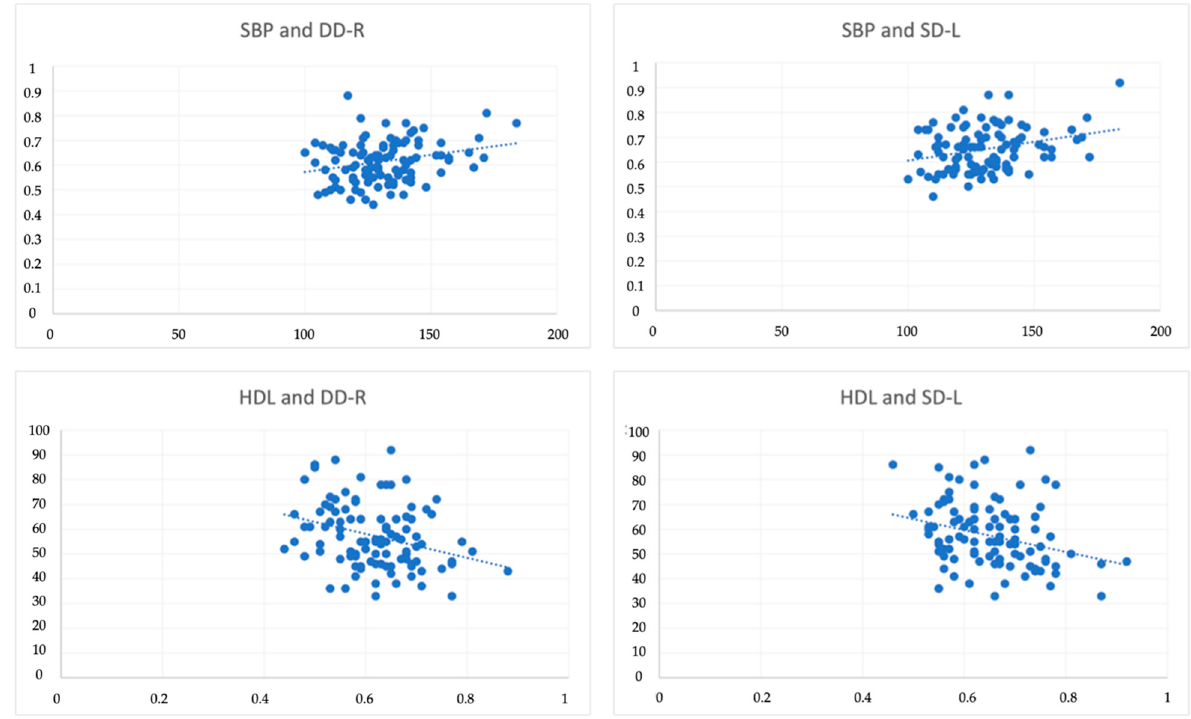
Figure 3. Relationships between SBP-DD-R and SBP-SD-L, and HDL-DD-R and HLD-SD-L. Notes: systolic blood pressure (SBP), diastolic diameter—right (DD-R), systolic diameter—left (SD-L), high-density lipoprotein (HDL).